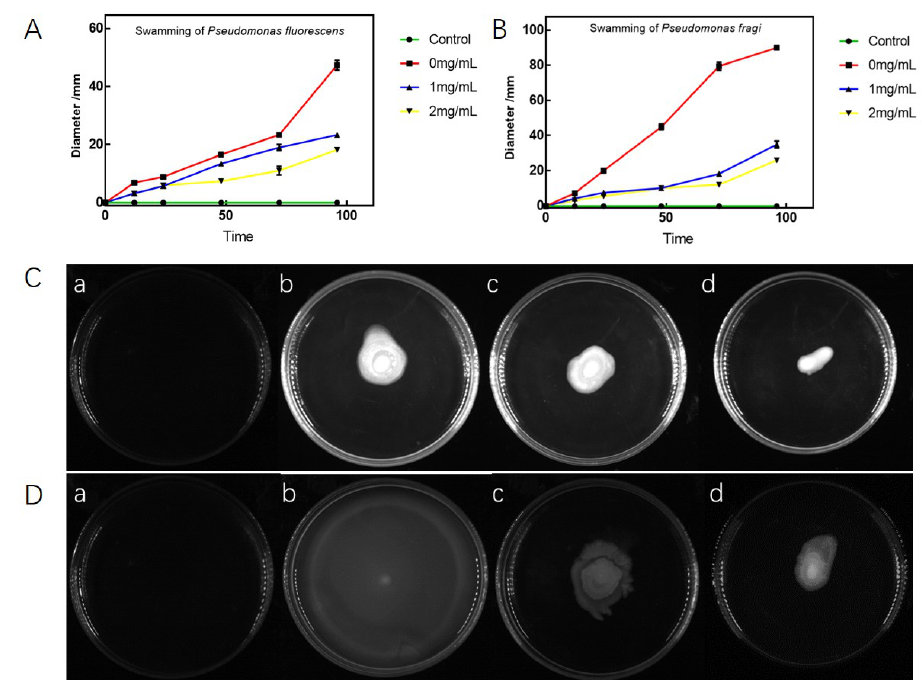
Figure 11. Antibacterial effects of D. algida on the swarming of the target Pseudomonas , where ( A , C ) are the diameter and appearance, respectively, of the inhibition zone of P. fluorescens , while ( B , D ) are the diameter and appearance, respectively, of the inhibition zone of P. fragi . The symbols (a–d) in the subfigures ( C , D ) represent control group, 0 MIC, 0.5 MIC, and 1 MIC, respectively. The data are shown as mean ± SD ( n =